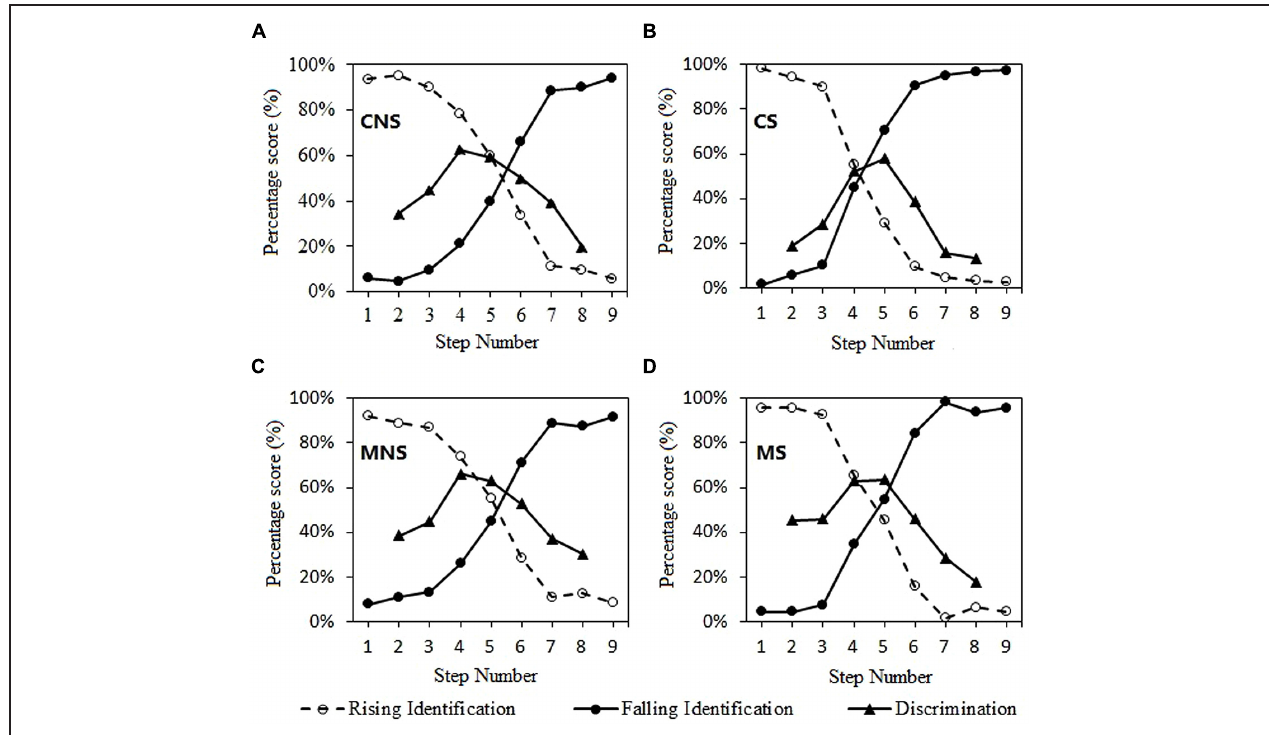
FIGURE 2 | Logistic identification functions and two-step discrimination curves. The “level” logistic response functions were plotted by reflecting the “falling” logistic response functions (Plevel = 1-Pfalling). The discrimination curves were obtained from proportion of “different responses.” (A) non-musician, non-speech; (B) non-musician, speech; (C) musician, non-speech; (D) musician,